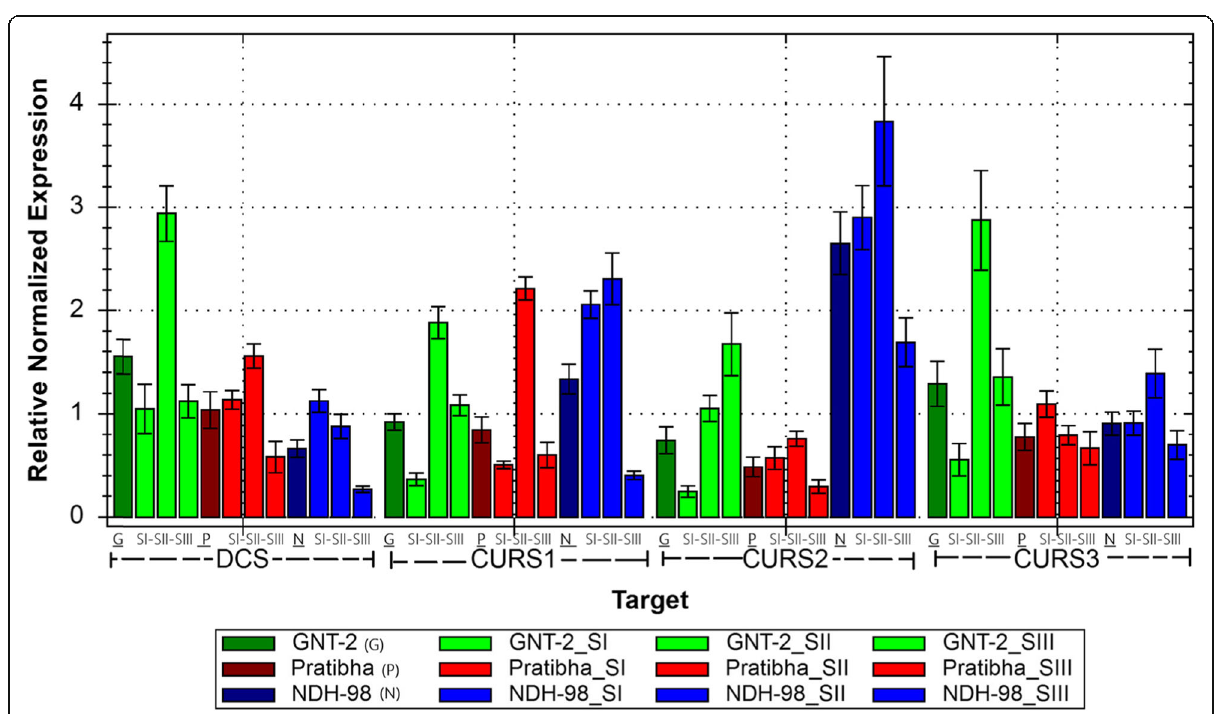
Fig. 1 Comparative gene expression analysis in turmeric cultivars at three stages of growth. Gene expressions were normalized to the reference gene Actin . Green colored bars represent GNT-2, red-colored bars represent Pratibha, and dark blue colored bars represent NDH-98. The first bar in each gene family is the average of the three stages SI, SII, and SIII of each cultivar, i.e., GNT-2 (G), Pratibha (P), and NDH-98 (N). In NDH-98, DCS expression is decreasing at all stages of growth from SI to SIII, CURS1 , and CURS2 expression is higher at SI and SII and decreased at SIII whereas higher expression of CURS3 at SII stages under study. In the case of GNT-2, DCS , CURS1 , and CURS3 are highly expressed at SII than SI and SIII, the CURS2 expression level is increasing throughout the growth stages from SI to SIII where DCS and CURS3 have almost equal expression level at SII in GNT-2. For Pratibha, DCS , CURS1 , and CURS2 gene expressions are higher at SII as compared with SI and SIII, and CURS3 gene expression is decreasing at all stages of growth from SI to SIII. A significant amount of gene expression variation was observed during SII (5 months